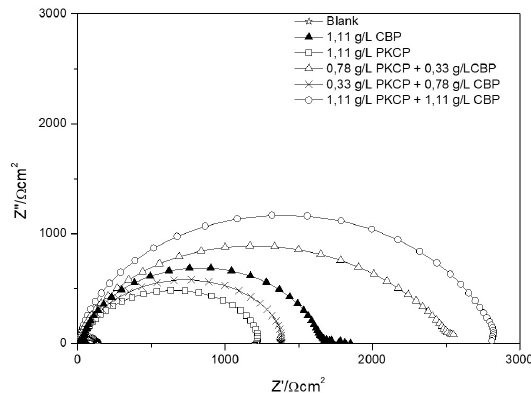
Figure 3. Nyquist diagrams of ASTM 1020 carbon steel in a 0.5 mol.L -1 HCl solution with various CBP and PKCP concentrations.